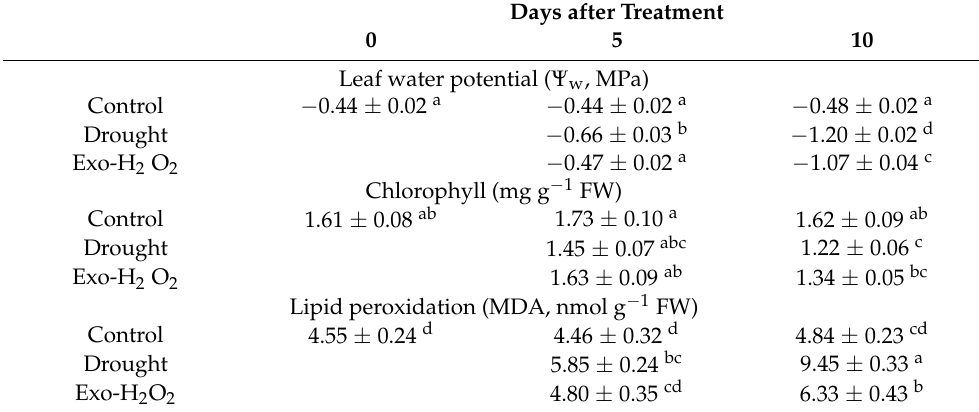
Results are represented as mean ± SE for n = 3. Different letters in a vertical column or a horizontal row indicate values that are significantly different at p < 0.05 according to Duncan’s multiple range